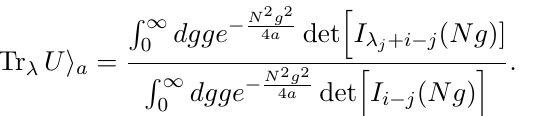
Figure 16. Plot of the expectation value of the winding Wilson loops u k = 1 adjoint model for k = 1 ; 2 ; 3. The red dots are the numerical values at N = 30, while solid curves represent the large N result in